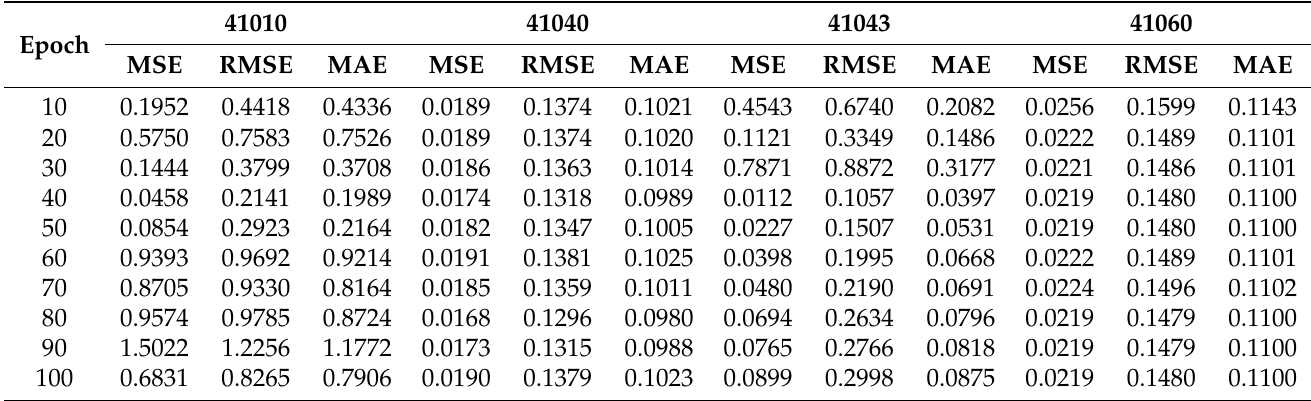
Table 8. Results of the original VRNN model in all datasets.